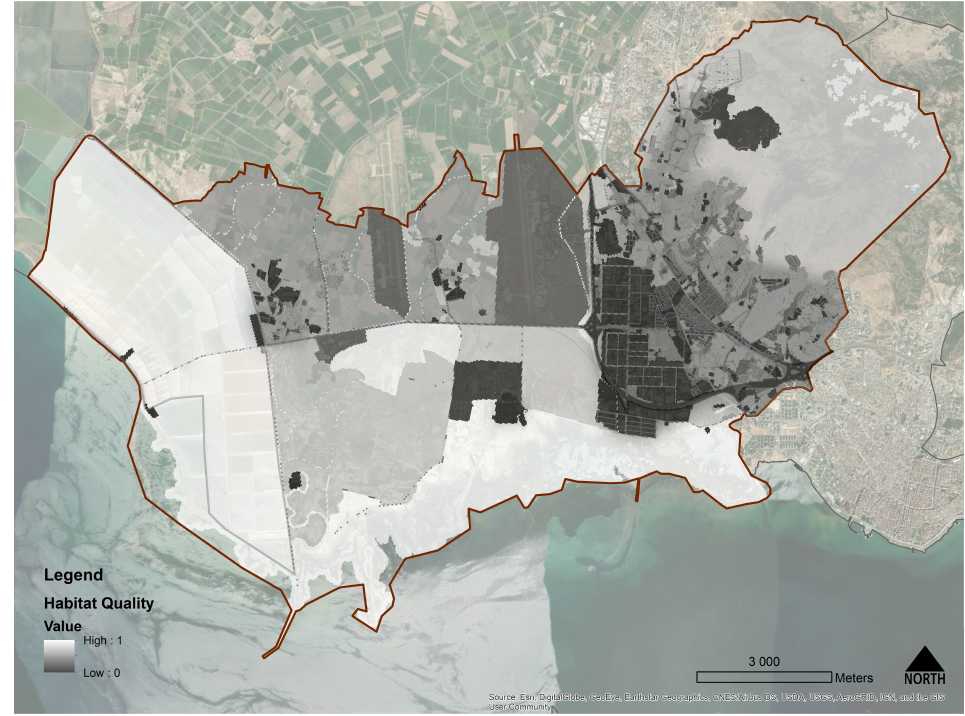
Figure 6. Habitat Quality values of Çi ğ li district (source: author’s elaboration).